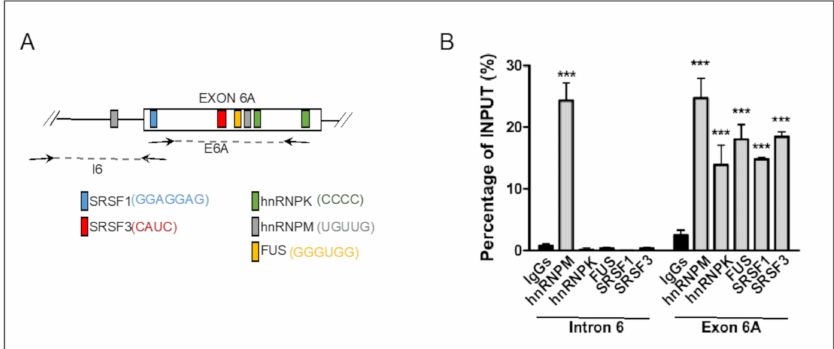
Figure 4. SRSF1, SRSF3, hnRNPK, hnRNPM, and FUS bind DHX9 exon 6A. ( A ) In silico analysis was performed using the Splice Aid database to identify putative consensus motifs for RBPs in the exon 6A sequence. In (A), schematic representation of DHX9 alternative exon 6A, with the position of SRSF1 (blue), SRSF3 (red), hnRNPK (green), hnRNPM (grey), and FUS (yellow) binding sites. Arrows indicate the primers’ positions used for the amplicons along the sequence. ( B ) TC-71 cells were UV-crosslinked, and protein-RNA extracts were immunoprecipitated with either control IgGs or hnRNPM, hnRNPK, FUS, SRSF1, and SRSF3 antibodies. Experiments were performed at least three times. Histograms show RT-qPCR analysis of the cross-linked and immunoprecipitation (CLIP) assay to analyze the binding of the indicated RNA binding proteins (RBPs) to intron 6 and exon 6A of DHX9 pre-mRNA. Results are expressed as a percentage of input ( ± S.D.). Statistical analysis was performed by one-way ANOVA with Bonferroni post-hoc test ( p -value: *** <